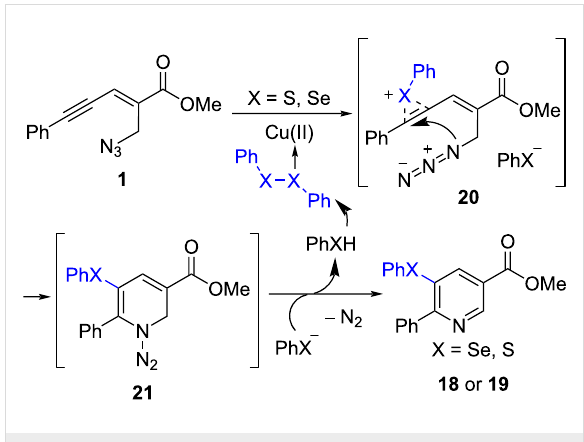
Scheme 8: The possible mechanism of